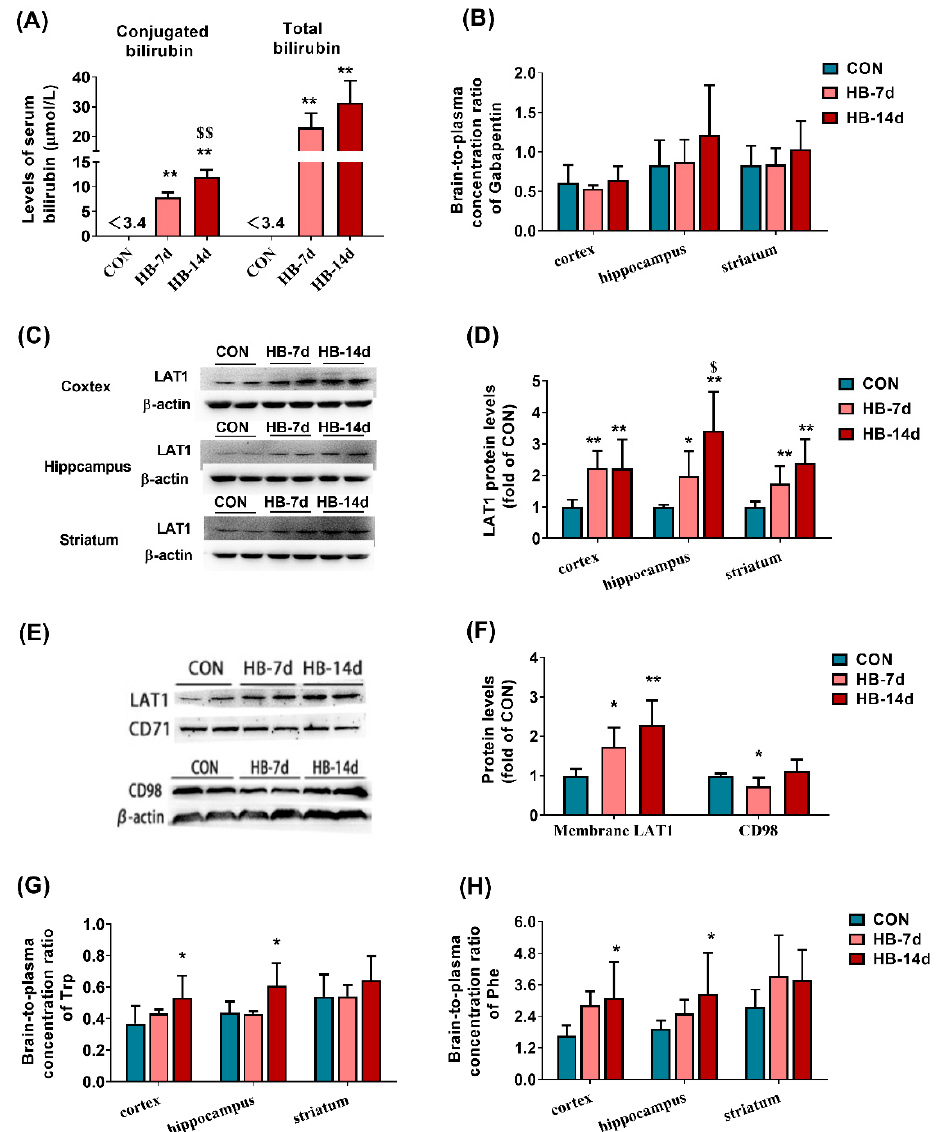
Figure 4. Effects of UCB treatment on LAT1 function and expression in the brain of rats. The levels of total bilirubin and conjugated bilirubin in serum ( A ) and the brain-to-plasma concentration ratio of gabapentin in the cortex, hippocampus, and striatum ( B ). Levels of total LAT1 protein ( C , D ) in the cortex, hippocampus, and striatum. The expression of CD98 and membrane LAT1 protein ( E , F ) in rat cortex. The brain-to-plasma concentration ratio of Trp ( G ) and Phe ( H ) in cortex, hippocampus and striatum. Hyperbilirubinemia rats (HB). Data are presented as the mean ± SD ( n = 5). * p < 0.05 and ** p < 0.01 versus CON rats. $ p < 0.05 and $$ p < 0.01 versus HB-7d